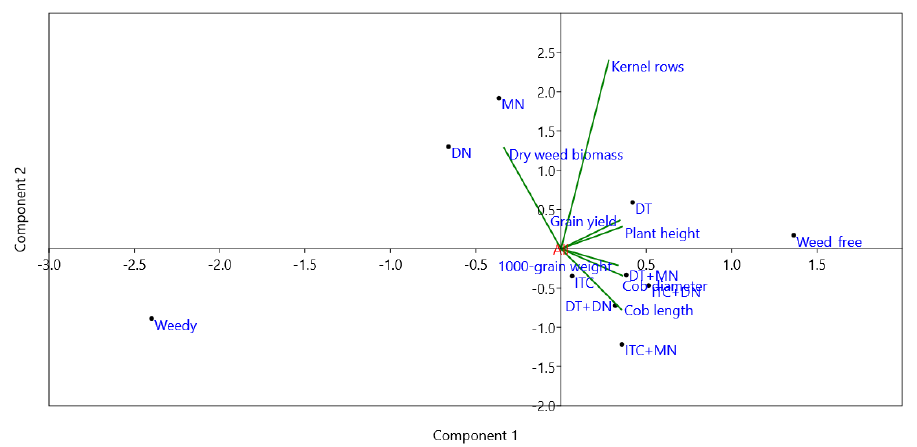
Figure 9. Network plot analysis of the treatments.